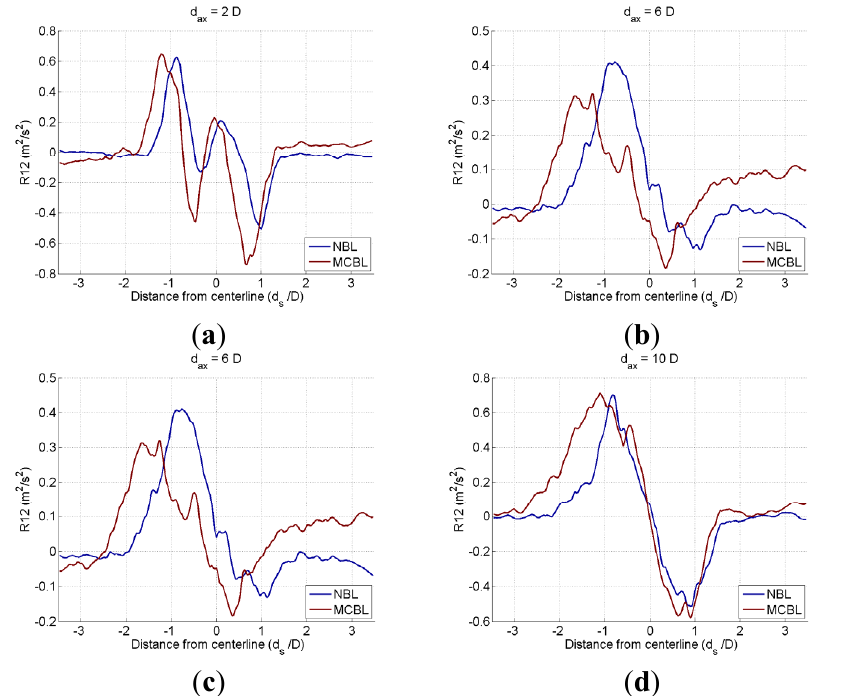
Figure 13. Reynolds stress R 12 distribution in the horizontal direction. (Turbine-Turbine Interaction Problem, V Wind = 8 m/s). ( a ) 2D downstream of Turbine 1; ( b ) 6D downstream of Turbine 1; ( c ) 2D downstream of Turbine 2; ( d ) 6D downstream of Turbine 2.